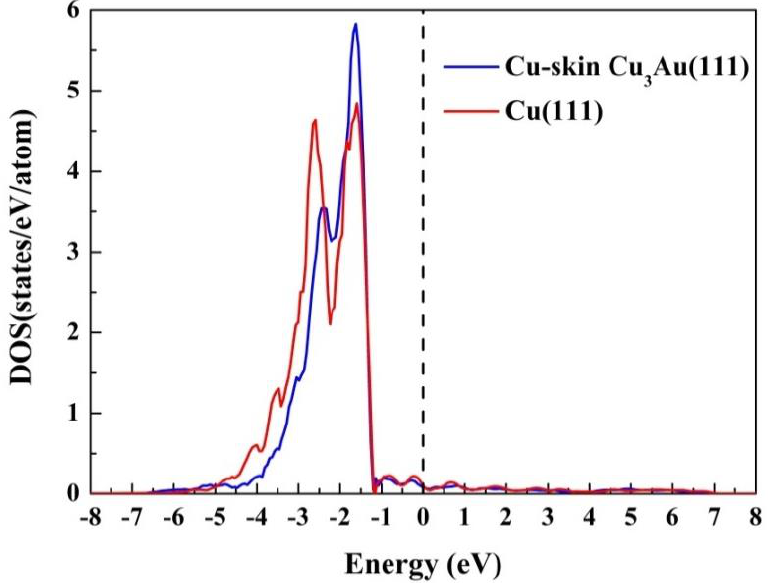
Figure 3. The calculated densities of states (DOS) of the Cu atoms in the Cu-skin Cu 3 Au(111) and Cu(111) surfaces. The d-band DOS of surface Cu atoms on Cu(111) is presented for comparison.